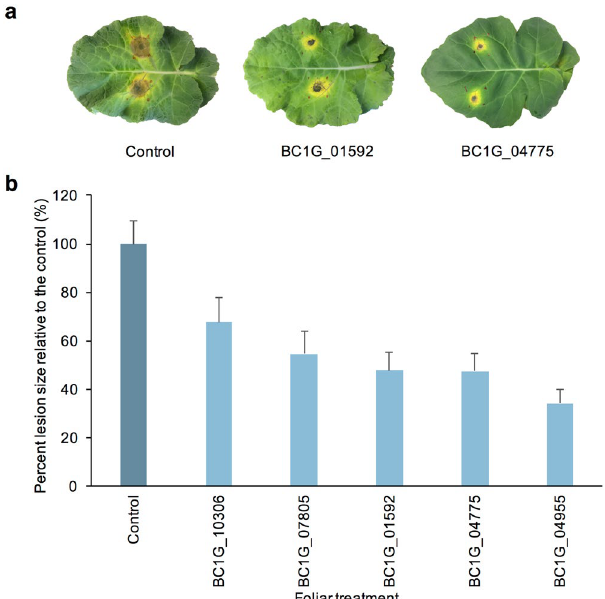
Figure 7. Botrytis cinerea homologues targeted with foliar dsRNA controls fungal infection ( a ) B . cinerea spore inoculation of B . napus cv . Westar leaves after an application of 500 ng of dsRNA targeting B . cinerea genes was spread over a 4 cm 2 area at 4 dpi. ( b ) Average lesion size compared to control (darker bar) with 4 bioreps of 10 leaves each (n = 40). Error bars represent standard error. All targeting dsRNA treatment were significantly different from GFP control (student’s t-test with Bonferroni correction, p <